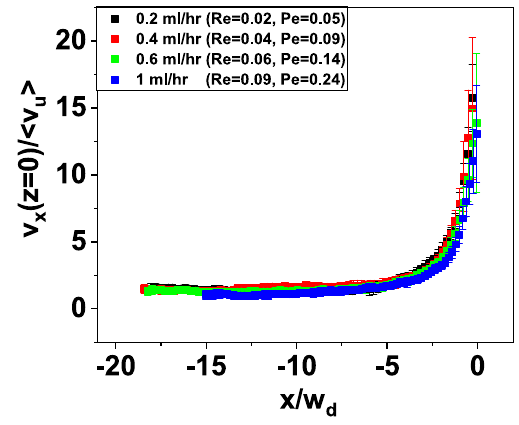
Fig. 6 The non-dimensionalized axial velocity profiles along the z = 0 line measured for the 300 g/L BSA solution through the “26-